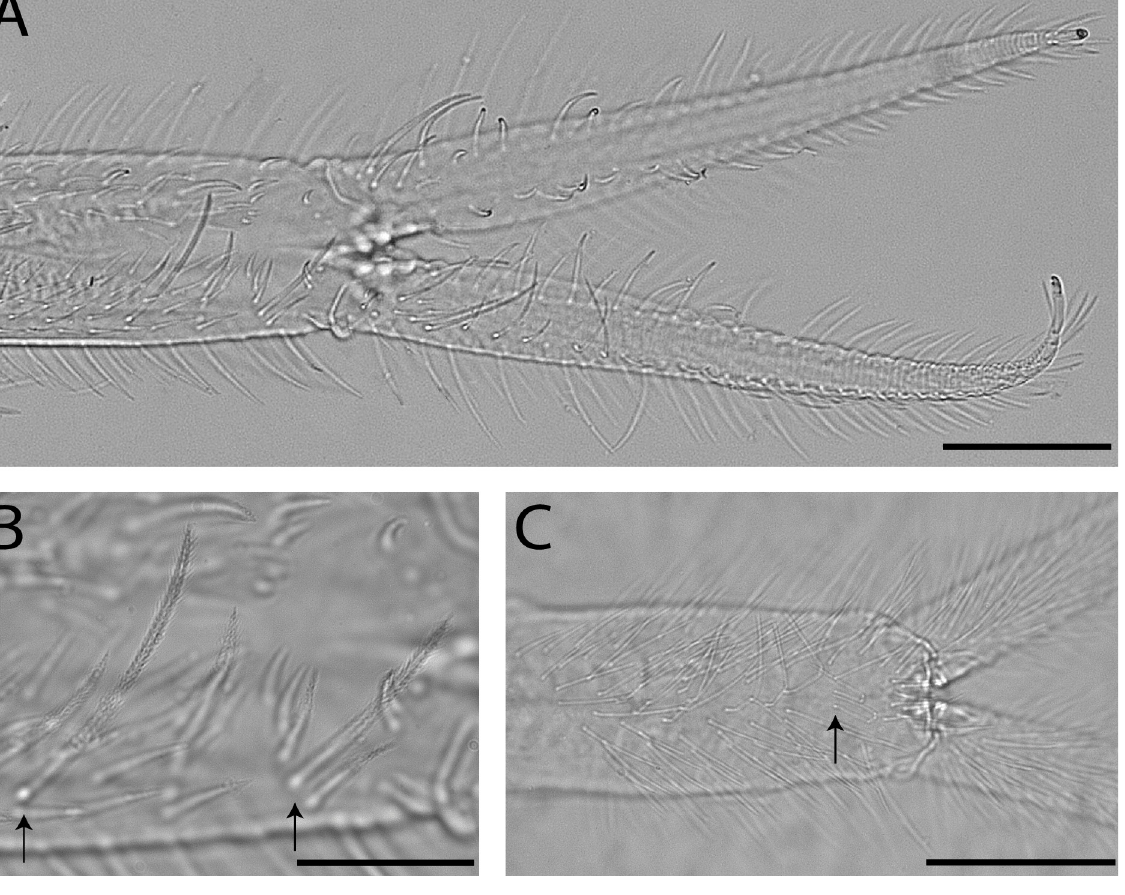
Fig. 4. Optical microscope photography of Willowsia nigromaculata (Lubbock, 1873). A . Furcula (dorsal view). B . Manubrium (dorsal view), arrows indicate mac and mes suddenly acuminate, respectively. C . Manubrium and proximal dentes (ventral view), arrow indicate subapical chaetae. Scale bars: A, C =100 μm; B = 50